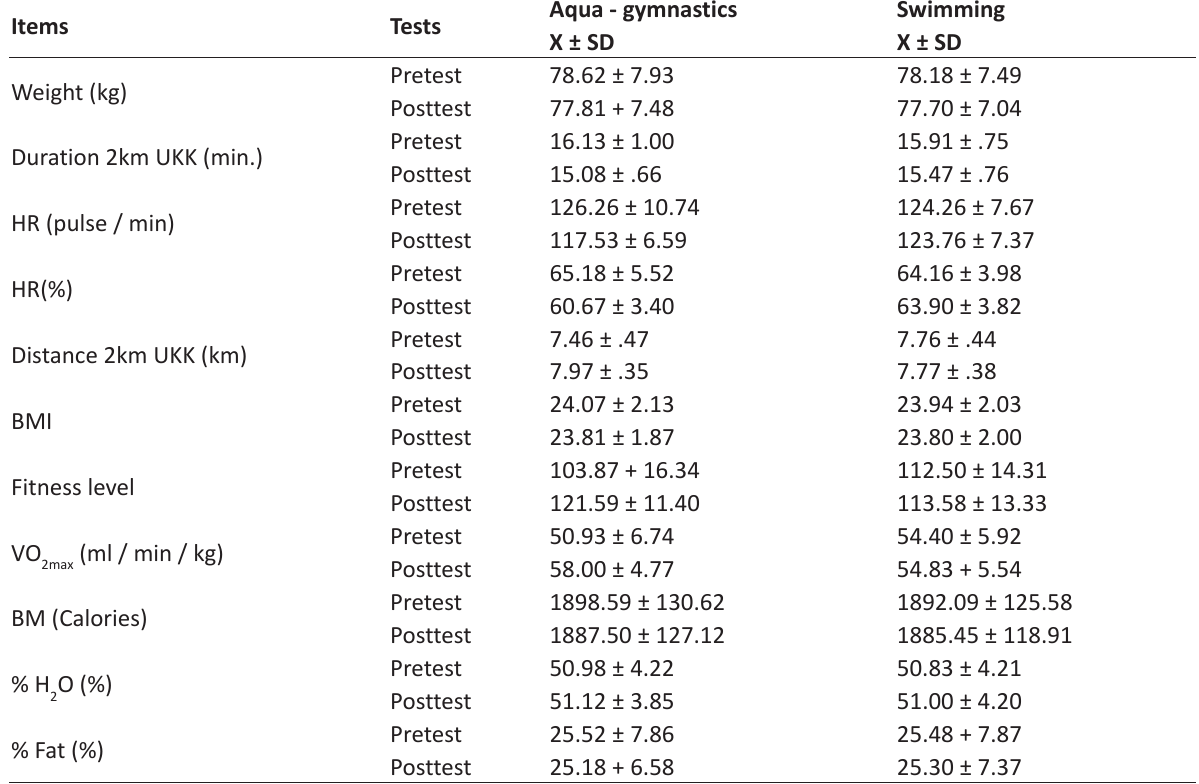
Table 1 . Descriptive statistics for the results of the tests of somatic and functional for aqua-gymnastics group and swimming group, pretest and post-test Items